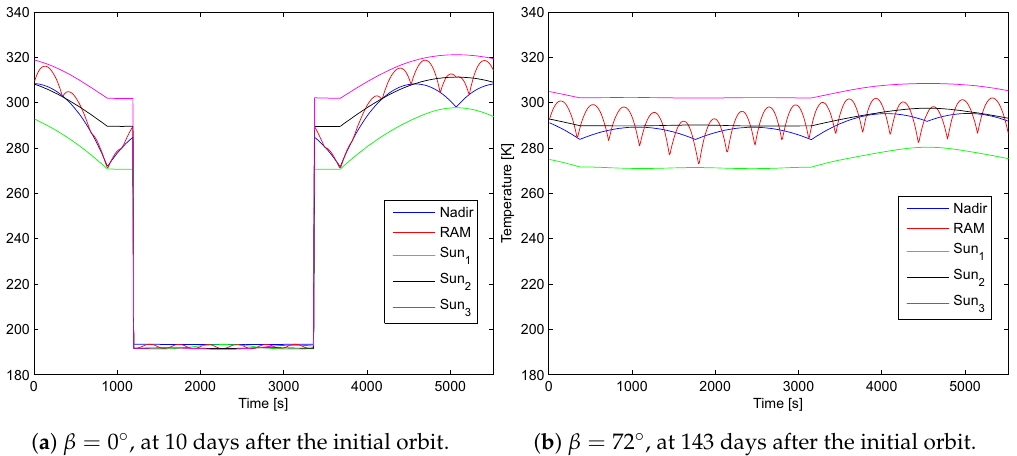
( b ) β = 72 ◦ , at 143 days after the initial orbit. Figure 12. Average temperature at steady-state for each attitude, with TLE1 and perturbation “Drag: NLMSISE-00, J 2 ”.